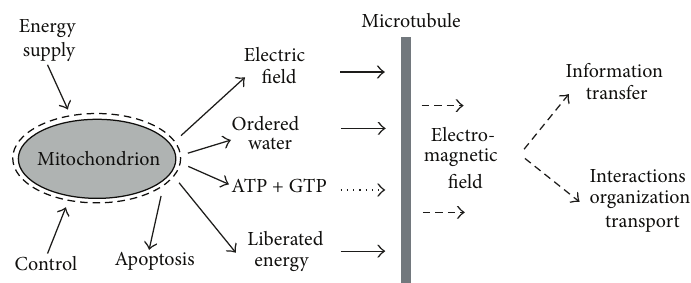
Figure 1: Biophysical mechanisms of biological activity of living cells depend on cooperation of mitochondria and microtubules.